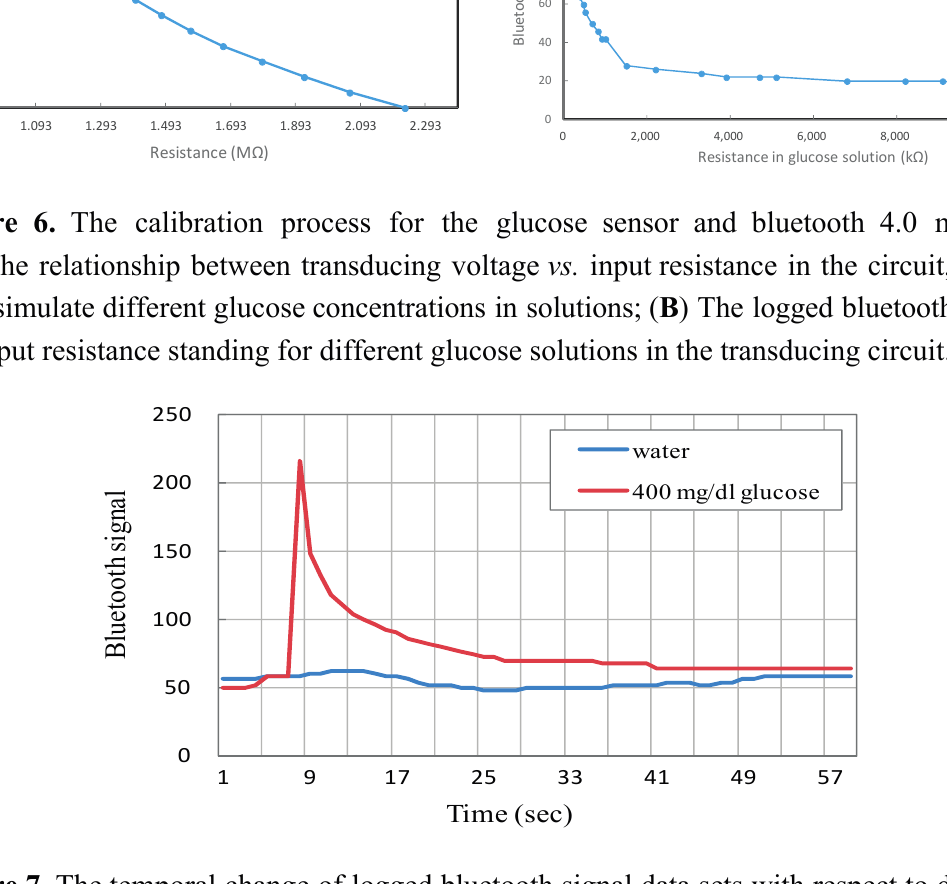
Figure 7. The temporal change of logged bluetooth signal data sets with respect to distilled water and a 400 mg/dL glucose